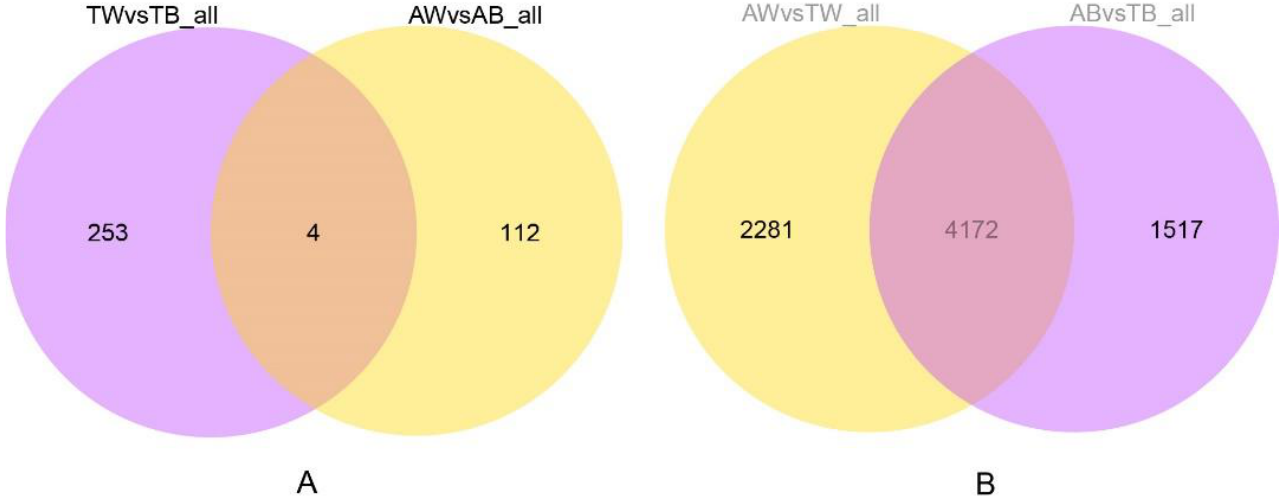
Figure 6. Venn diagram of differentially expressed genes in mink of ( A ) different hair colors showing the overlap between two age groups and ( B ) different age groups showing the overlap between two coat color groups.